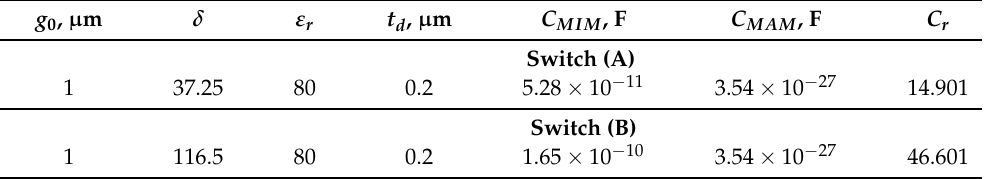
Table 8. The results of calculation of the MIM capacitors of switch (A) and switch